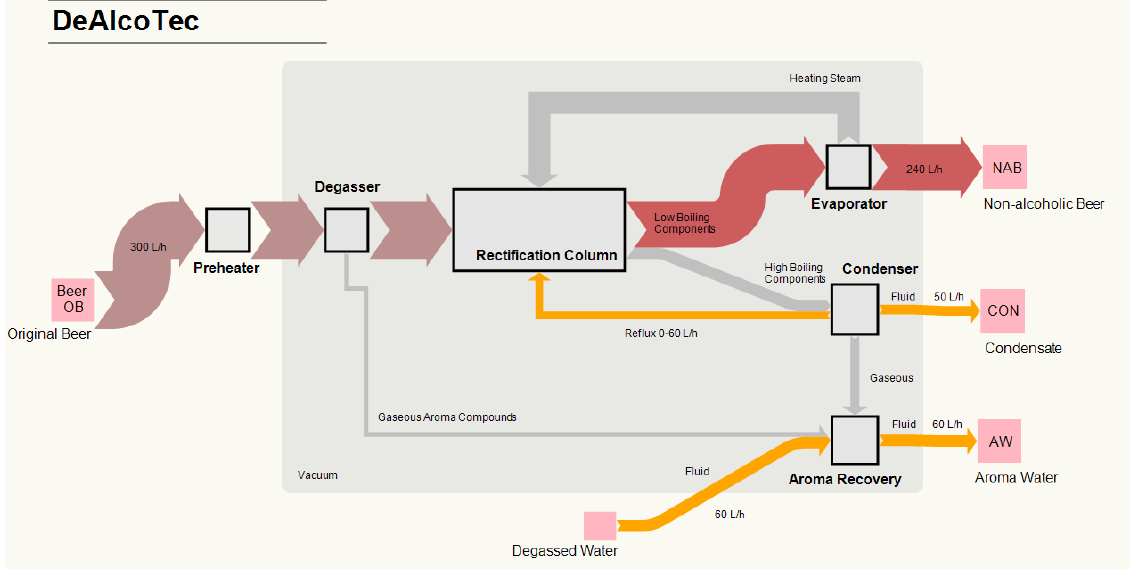
Figure 1. Representation of the flow scenarios in the DeAlcoTec ® thermal dealcoholisation system, which was used to process the original beer (beer OB) samples. The pink squares represent the initial beer OB and final products non-alcoholic beer (NAB), condensate (CON) and aromawater (AW). The quantitative flows of the individual gaseous (grey arrows) and liquid (red, orange and lilac pale blue arrows) media illustrate the continuous dealcoholisation and aroma recovery processes, which are linked as an overall process. The black square rectangles identify the single unit operations in the